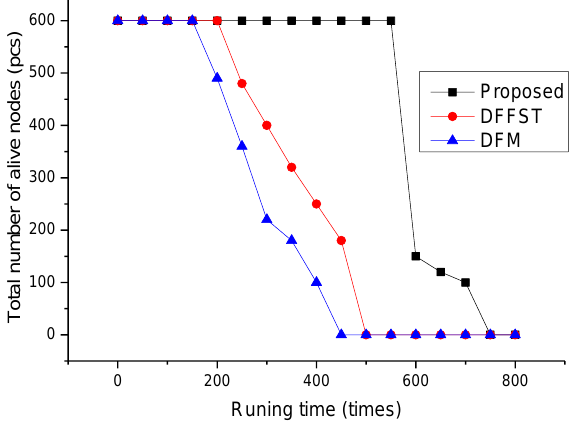
Figure 3. Relationship between the number of network runs and the total number of surviving sensor nodes. sensor